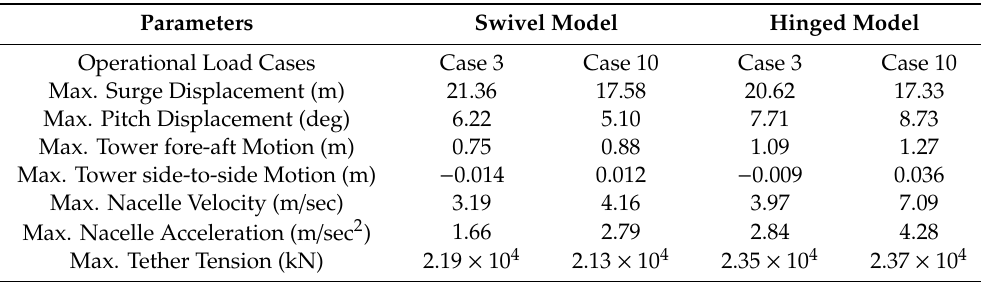
Table 11. Peak values of swivel and reference model.